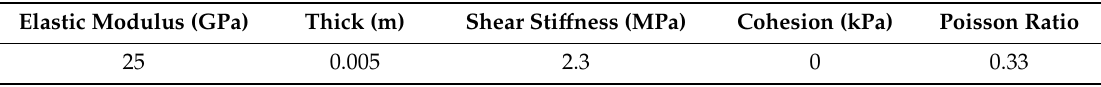
Table 9. Mechanical parameters of the soil sample.